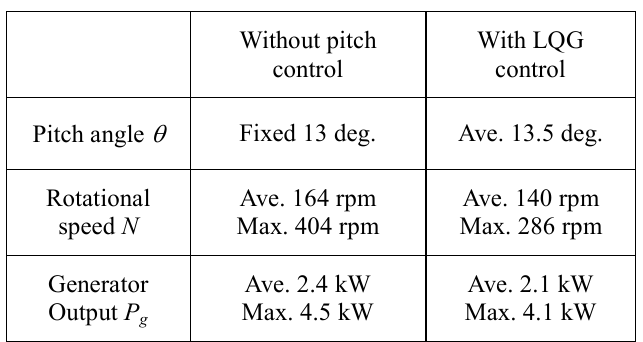
Table 3 Simulation